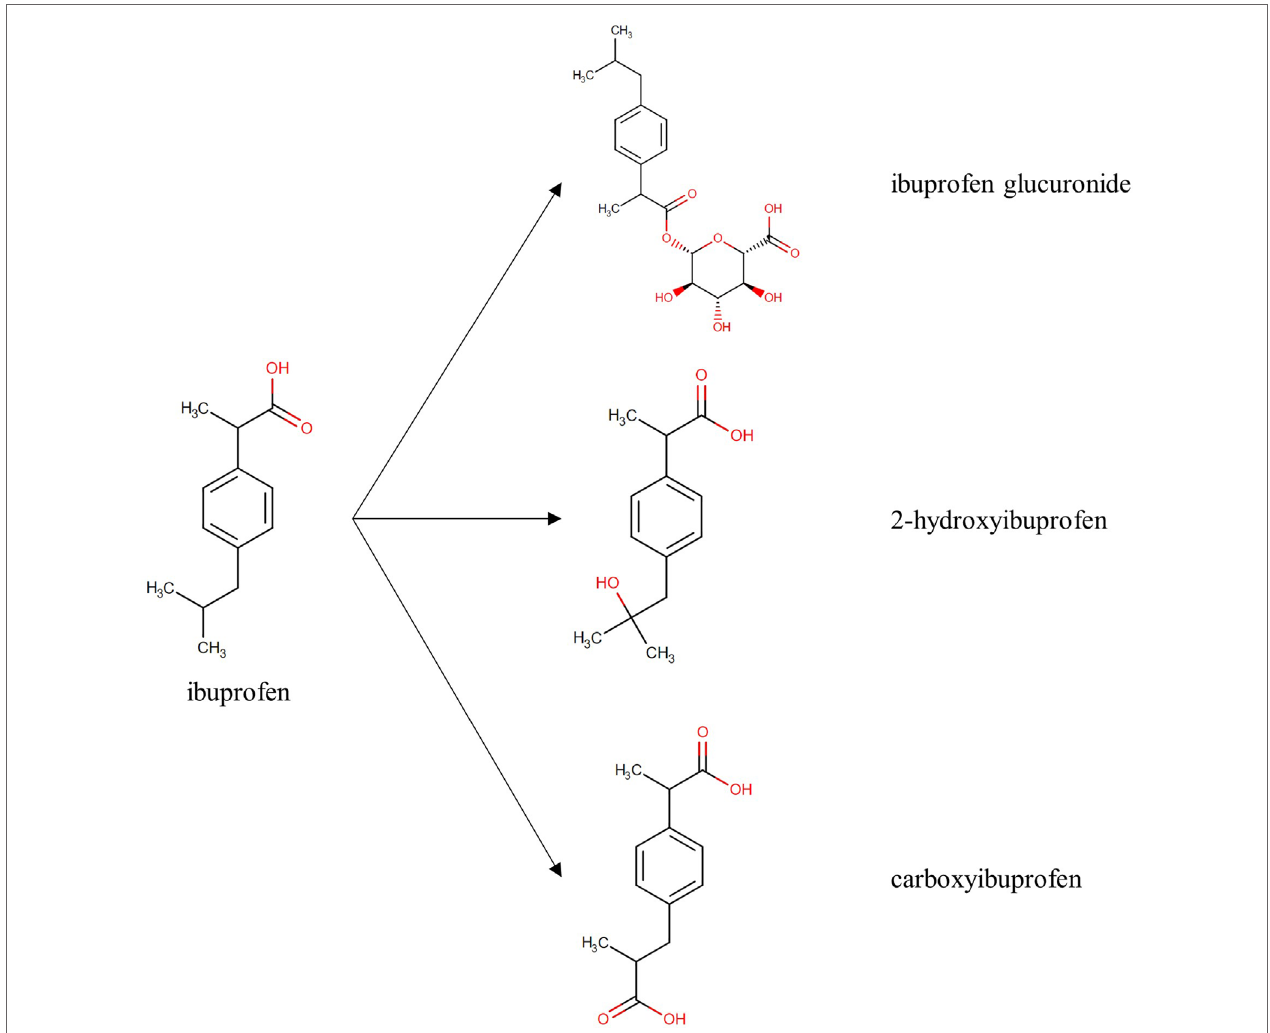
FIGURE 1 | Chemical structure of ibuprofen and its metabolites, ibuprofen glucuronide, 2-hydroxyibuprofen, and carboxyibuprofen. Structures are derived from Drugbank 1 . (Wishart et al.,